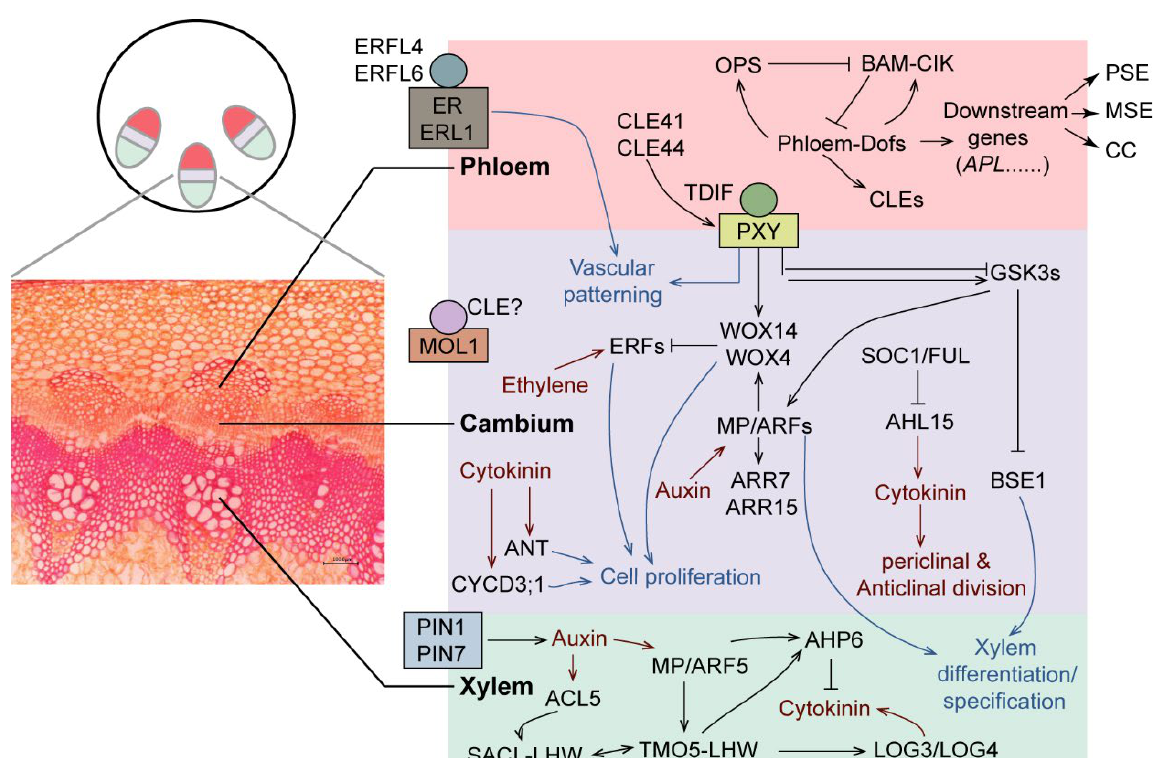
Figure 1. Complex genetic networks involving multiple transcription factors and phytohormones underlying vascular tissue specification. Individual vascular bundles composed of procambial cells between xylem (inner) and phloem (outer) in dicot angiosperms. Phloem formation, Phloem-Dofs activate the production of secretory CLE peptides, which are perceived by the BAM-CIK receptor system, reduce phloem-Dof proteins and repress formation of phloem cells. Phloem-Dofs also induce OPS, which is a negative regulator of BAM-CIK. The phloem-Dof positive feedback loop and the OPS-mediated BAM-CIK inhibition counteract the effect of CLE in SE- and CC-committed cells. Cambial specification PXY is activated by its ligands, CLE41 and CLE44. TDIF peptide as CLE family member is produced in the phloem and presumably moves to the cambium, where it binds to its receptor PXY and upregulates the expression of WOX4 and WOX14, resulting in cell proliferation in the cambium. Together with TDIF-PXY signaling, EPFL-ER signaling controls vascular pattern- ing. In addition, the PXY pathway activates BIN2, a GSK3 protein that inhibits the expression of the transcription factor BES1, control xylem differentiation, and cambium activity through phosphory- lation of MP/ARF5. Ethylene-induced ERFs, cytokinin-induced ANT, and CYCD3;1 are involved in cambial cell proliferation. The TDIF-PXY pathway also participates in crosstalk with hormonal path- ways including auxin, ethylene, and cytokinin. MORE LATERAL GROWTH 1 (MOL1) is another receptor that opposes PXY activity in cambium regulation. In a parallel pathway, the MADS box transcription factors SOC1 and FUL limit cambium activity by repressing AHL15 expression. AHL15, in turn, promotes cell division activity of the cambium by enhancing the expression of cy- tokinin biosynthesis genes. Xylem formation and auxin maximum in protoxylem cells induce the production of cytokinin through TMO5-LHW pathway. TMO5–LHW directly upregulated LONELY GUY 3 (LOG3) and LOG4 through cytokinin biosynthesis in the xylem axis, cytokinin diffuses to the procambium, where it promotes periclinal cell divisions and stimulates the auxin efflux carrier proteins PIN1 and PIN7, which direct auxin flow toward the protoxylem. Auxin also induces AHP6 expression and suppresses cytokinin signaling in the protoxylem. ACL5 antagonizes TMO5-LHW activity by stimulating SACLs, which can also heterodimerize with LHW.